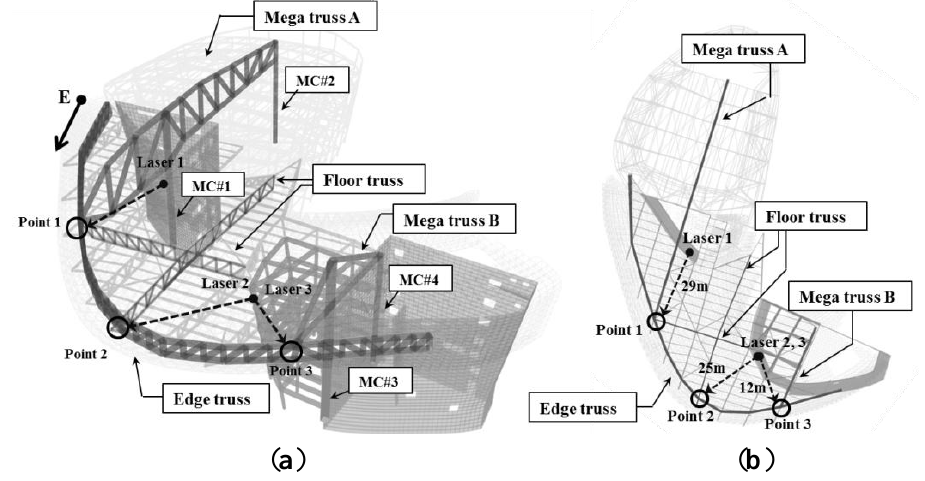
Figure 3. Target structure, D building. ( a ) Three-dimensional view of the main elements. ( b ) Cross-sectional plan of the main